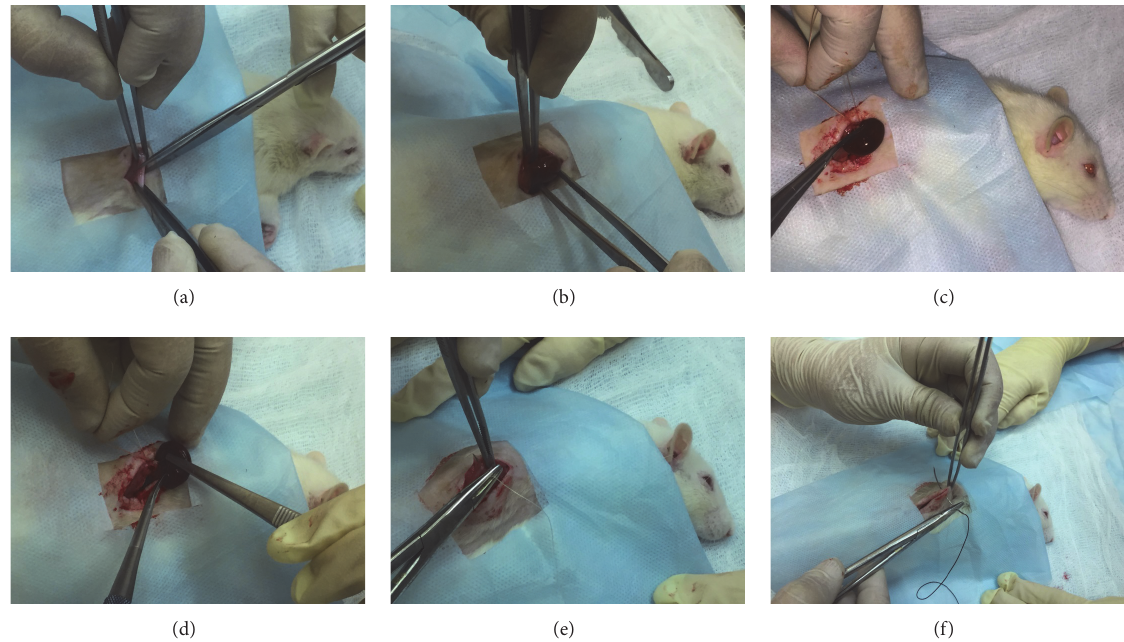
Figure 2: Surgical procedure of right-side nephrectomy. (a) After shaving under anesthesia, the right posterior and lateral abdominal wall is cleansed with skin antiseptic solution. Right vertical extra-peritoneal lumbar incision is performed. (b) Ligation of the right renal pedicle by 4/0 silk suture at two points. (c) Performing circular incision of renal capsule to prevent adrenal gland against extraction. (d) Separate enucleation and removing of the kidney. (e) Closing of the incision with simple continuous suture. (f) Closing of the skin with 2-0 silk simple intermittent